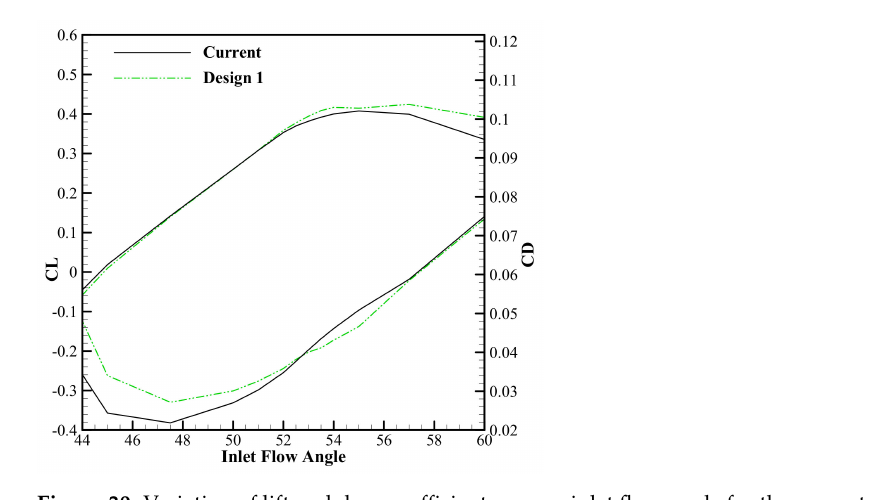
Figure 30. Variation of lift and drag coefficients versus inlet flow angle for the current and the second designed blade cascades.